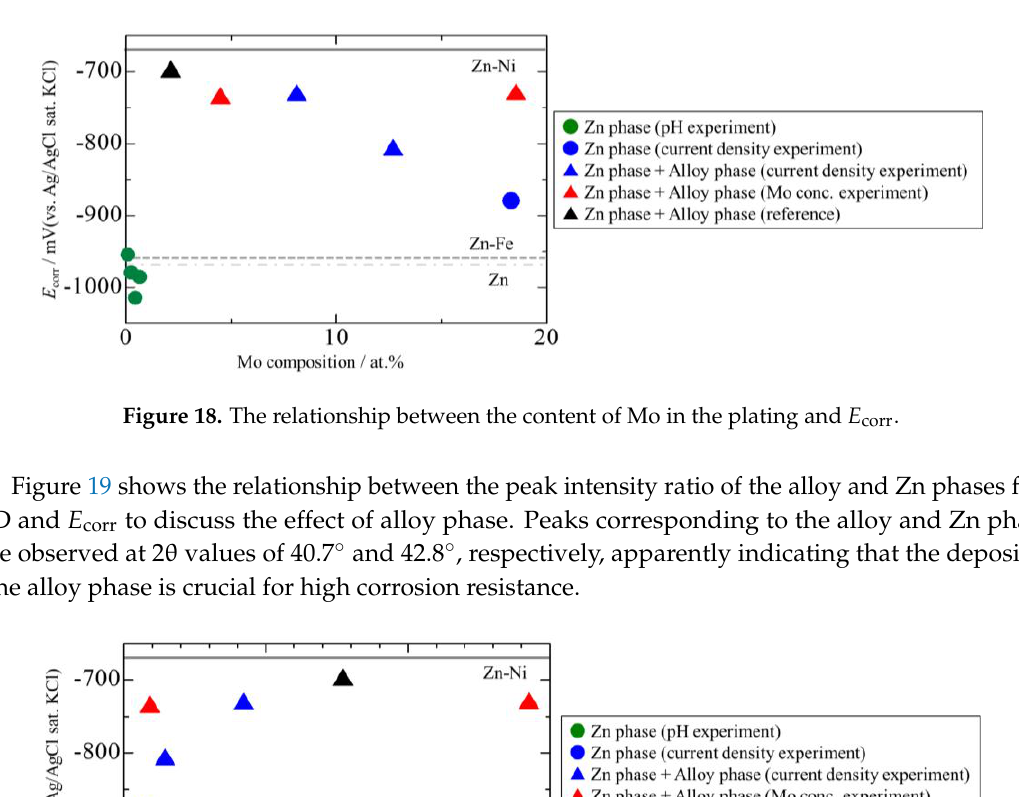
Figure 19. The relationship between the peak intensity ratio of the alloy phase and Zn phase from the XRD and E corr .